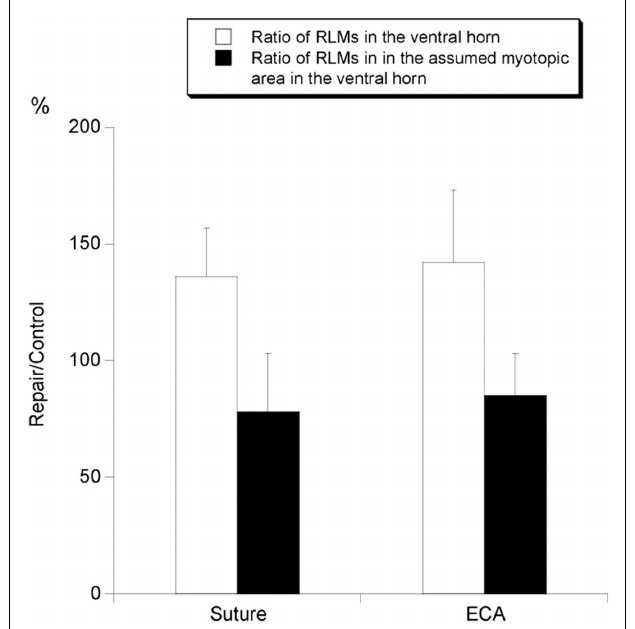
FIGURE 3 | Histograms representing quantification of RLMs, expressed as mean (SD), detected in the lateral ventral horn of the L5 spinal cord 6months after transection and repair of the left rat sciatic nerve with either ECA or epineural sutures. Each column shows the relation of the number of RLMs between repaired and control side, calculated as a percentage value. RLMs were counted within the ventral horn in total or within the assumed normal myotopic distribution area ( n = 8 in each group).